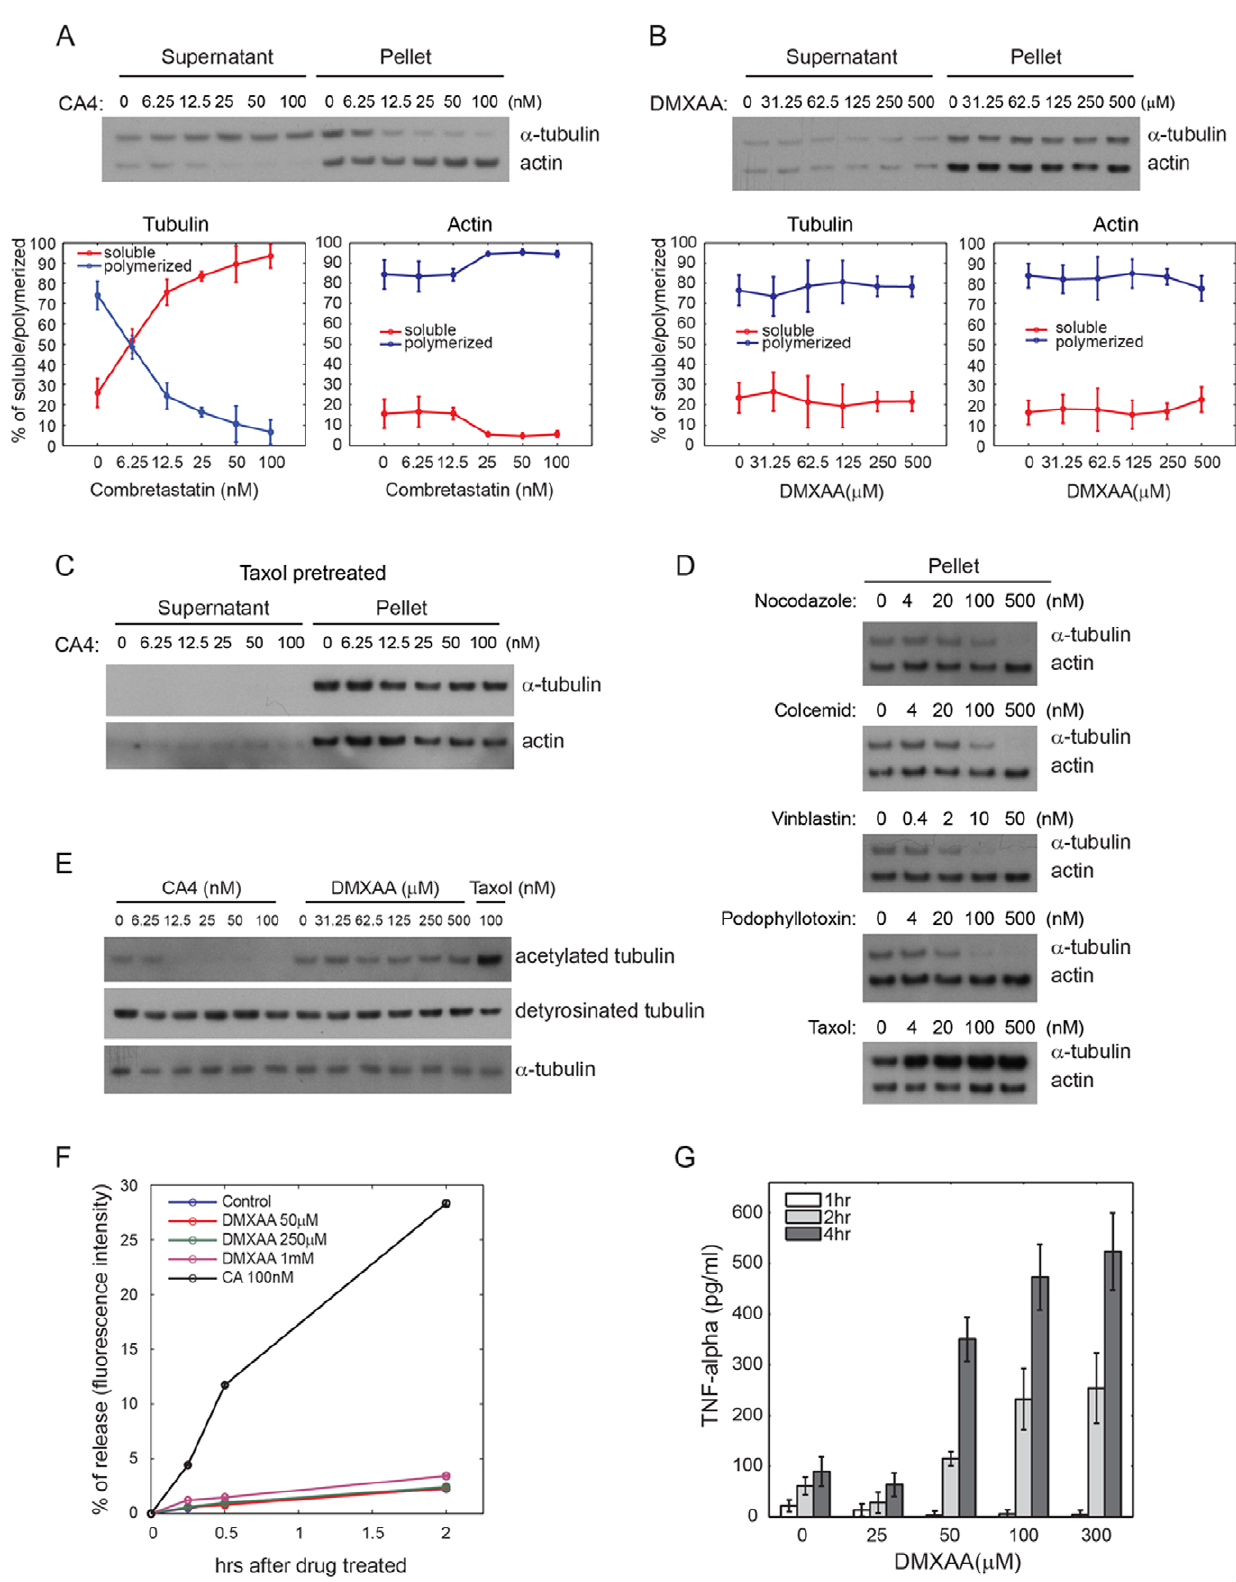
Figure 3. Quantitative analysis of the polymerization state of microtubules and actin in drug treated cells. (A) Soluble tubulin extraction assays were performed after treatment with serial dilutions of CA4 for 10 min. Tubulin and actin monomers were extracted from supernatant but polymerized tubulin and actin remained in the pellets. Each supernatant and pellet was subject to Western blotting to measure protein levels of tubulin and actin. The ratio of soluble vs. polymerized tubulin and actin are plotted in the lower panel. Error bars were calculated as